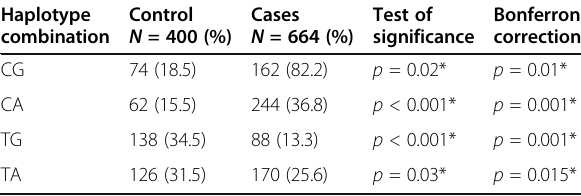
Table 9 rs1927911 genetic polymorphism distribution between cases and control Genotype rs1927911